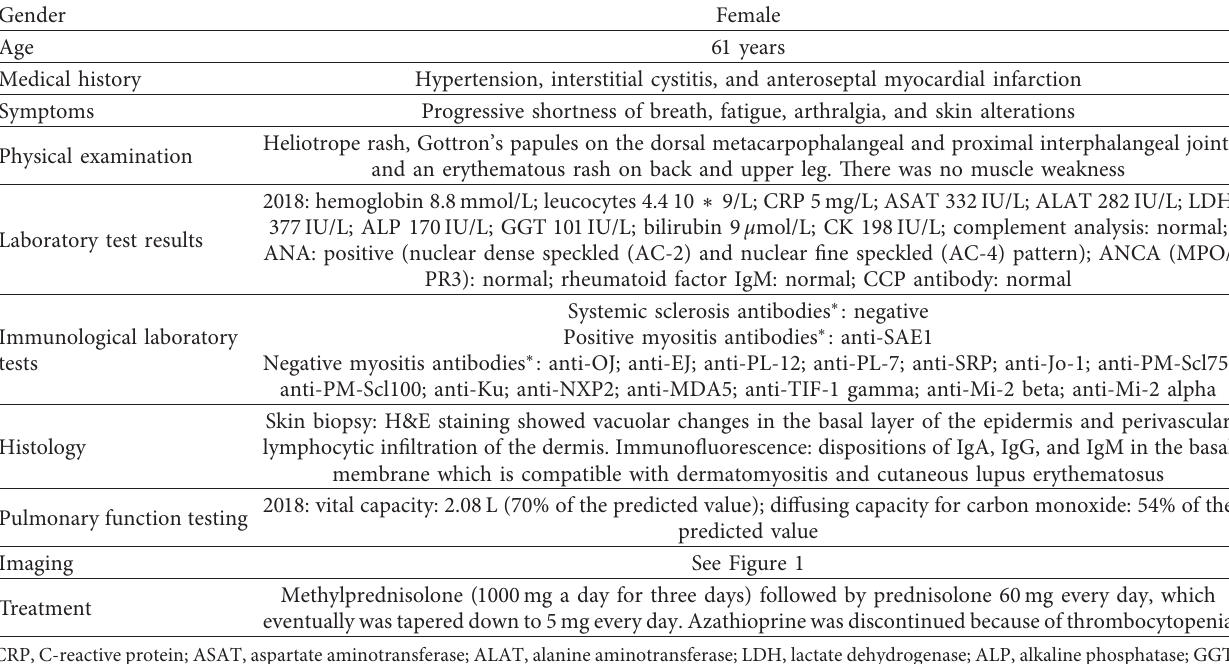
Table 1: Characteristics and the main clinical features of the